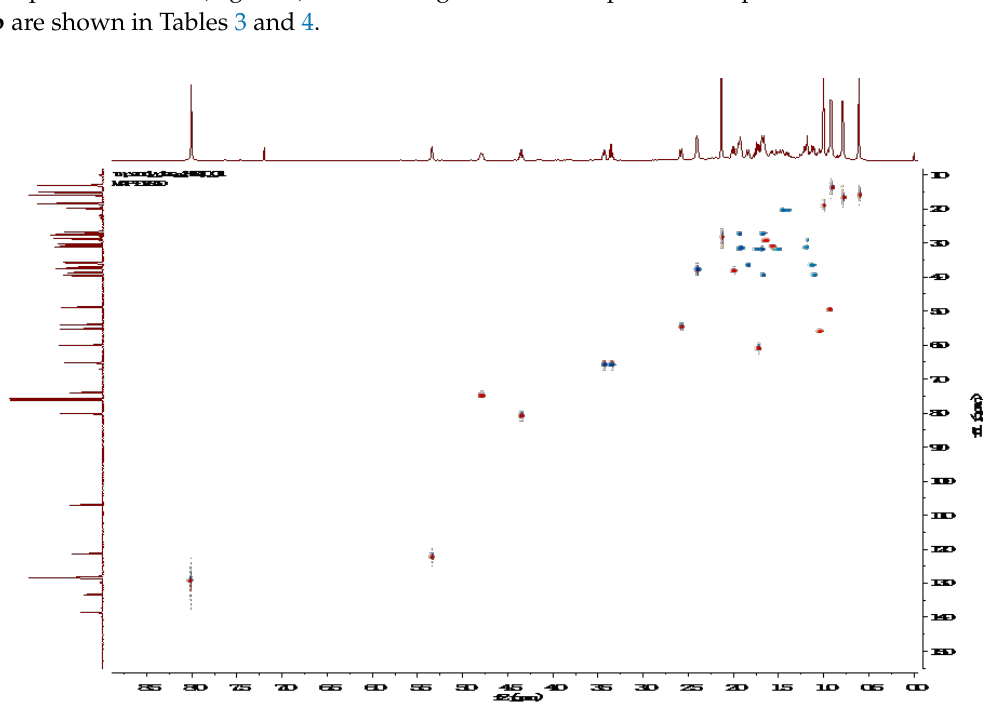
Table 3. Selected 1 H-NMR signals of the 8a – c and 10a – b in ppm.